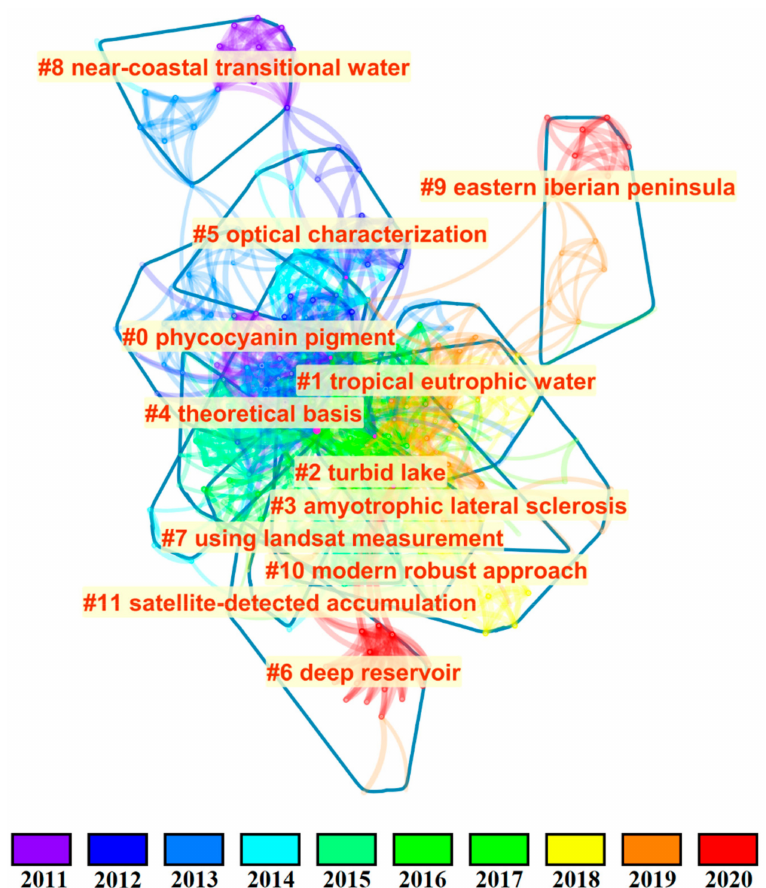
Figure 6. The co-citation network of remote sensing of PC publications clusters (2011–2020) and clusters’ labels extracted by LLR